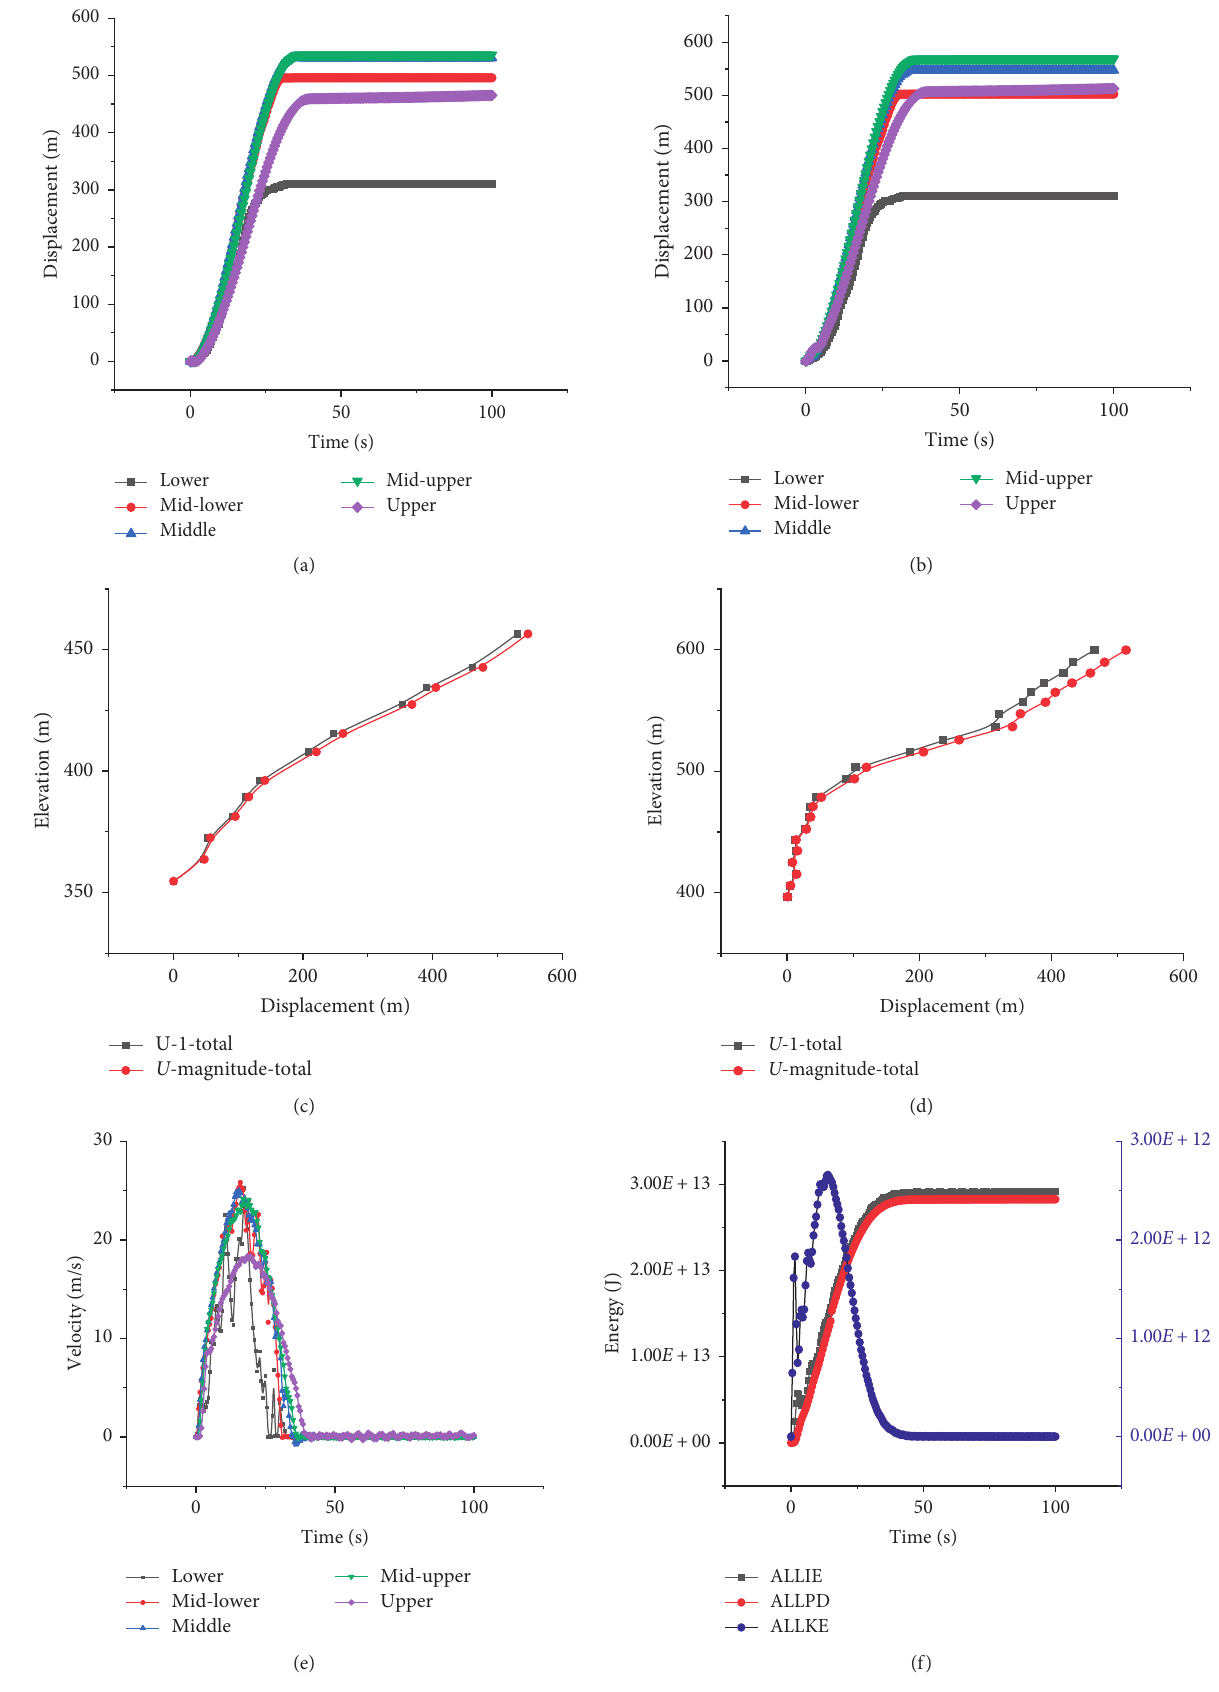
Figure 15: Typical monitoring quantities. (a) Displacement (U1) time curve at the 5 positions on the slope. (b) Displacement (U magnitude) time curve at the 5 positions on the slope. (c) Displacement in the vertical axis at the middle slope. (d) Displacement in the vertical axis at the slope shoulder. (e) Velocity-time curve at the 5 positions on the slope. (f) Energy-time